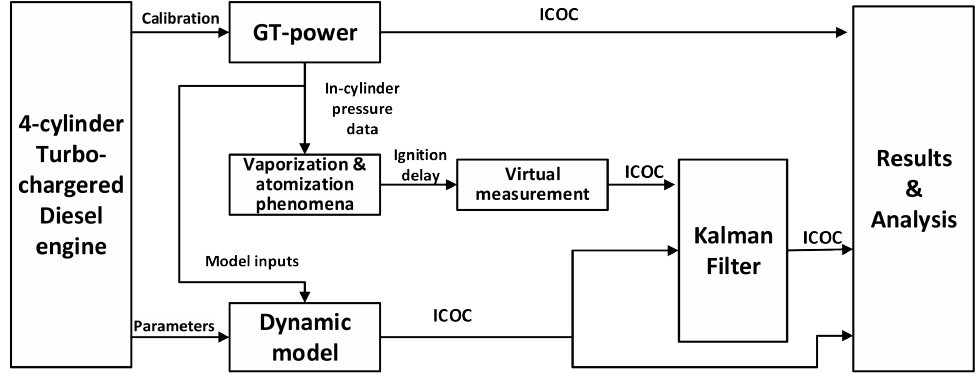
Figure 2. Work flow of the